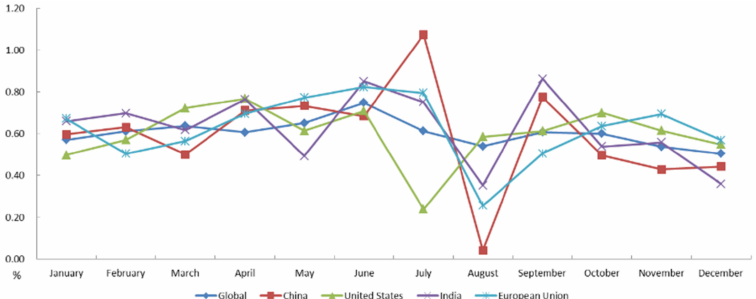
Figure 3. Monthly changes in CO 2 concentrations for global land and major countries/regions from 2021 to